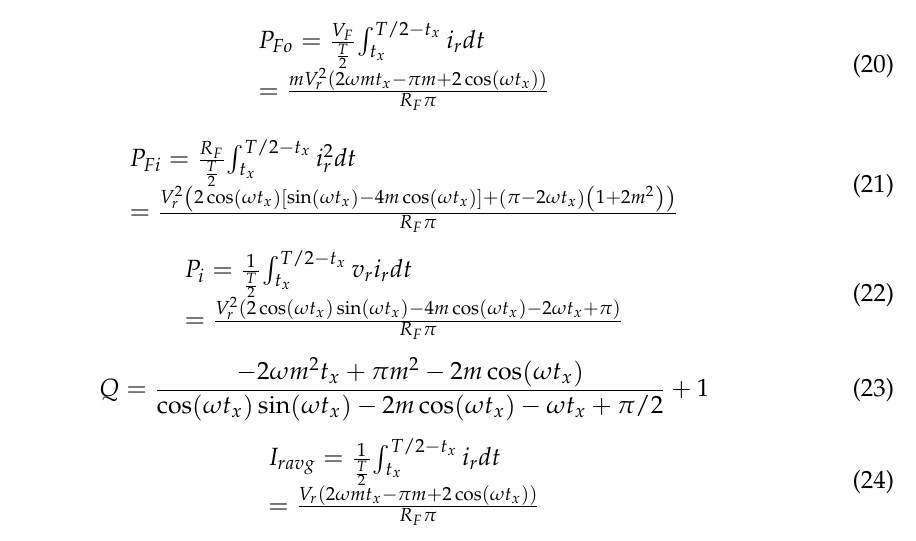
Table 2. Technical specifications of the LED test lamp.